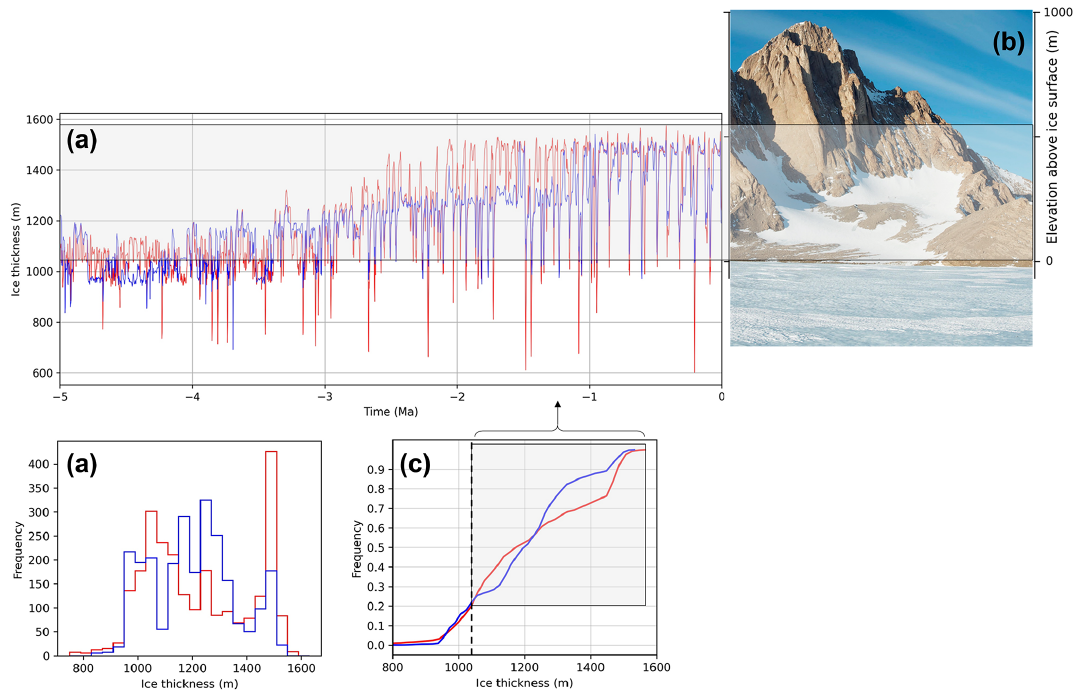
Figure 4. Example ice thickness change history at Mt Tidd, one of the nunataks comprising the Pirrit Hills, in the middle of the West Antarctic Ice Sheet (location shown in Fig. 7 central plot as “e”). (a) The sensitized model (red) displays larger variation in ice thickness and is more likely to occupy extreme values, whereas the desensitized model (blue) is more likely to occupy intermediate values. The resulting ice thickness histograms (b) and cumulative frequency distributions (CDFs) (c) are therefore distinct. (d) Photo of Mt Tidd, aligned on the same y axis as panel (a) . Grey shading in panels (a) , (c) , and (d) denotes the elevation range that is exposed above the present ice surface (so data can be collected) and where ice cover frequency reconstructions could distinguish between sensitized (red) and desensitized (blue) model behaviour. The dashed black line in panel (c) represents the modern ice thickness and is chosen to approximately align the range of ice thickness in the model simulation with that inferred from geologic evidence (establishing a modern ice thickness is further discussed in Sect.